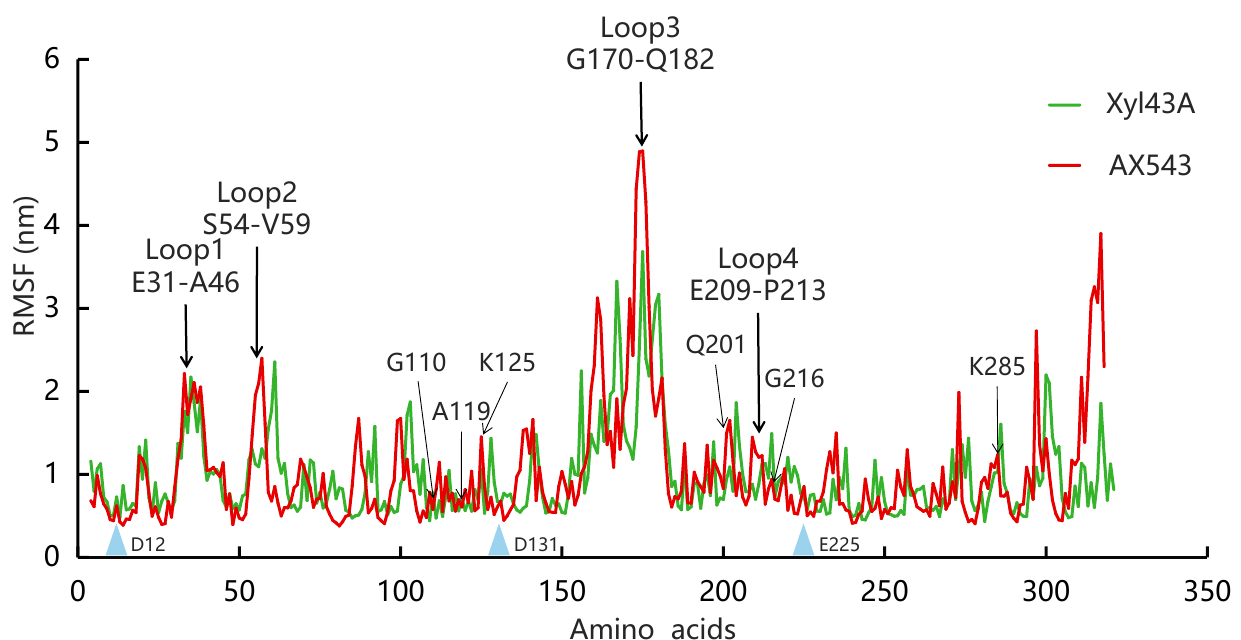
Figure 7. Molecular dynamics simulation and root mean square fluctuation (RMSF) of AX543 (red) and Xyl43A (green). The three conserved AX543 catalytic residues (Asp12, Asp131, and Glu225) are marked with blue triangles.